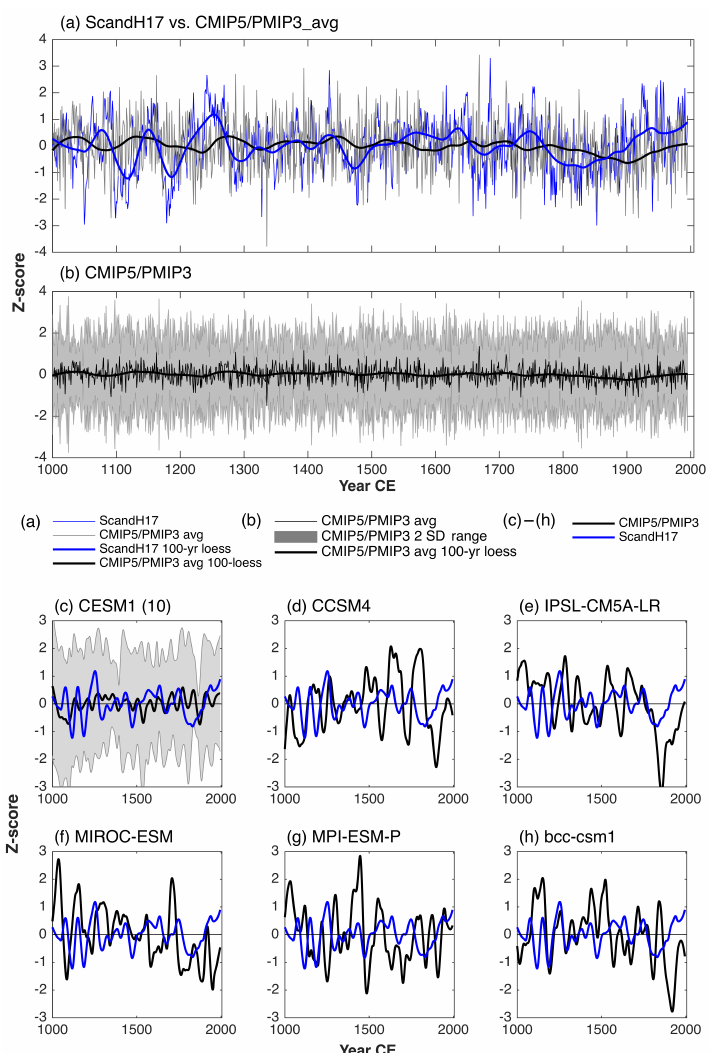
Figure 2. Comparison of reconstructed SPEI with forced model runs. (a) The reconstruction versus the mean of the six CMIP5–PMIP3 models transformed into standard normal deviates ( z scores) over the 1000–1995CE period and smoothed with a 100-year loess filter; (b) multi-model mean and the 2 standard deviation range (shading) of the six GCMs; (c) mean and 2 standard deviations (shading) of CESM1 10 smoothed and z -scored ensemble members (blue); (d) – (h) the reconstruction (blue) versus individual model runs (black). All time series have been smoothed with a 100-year loess filter and then z -scored over the 1000–1995CE